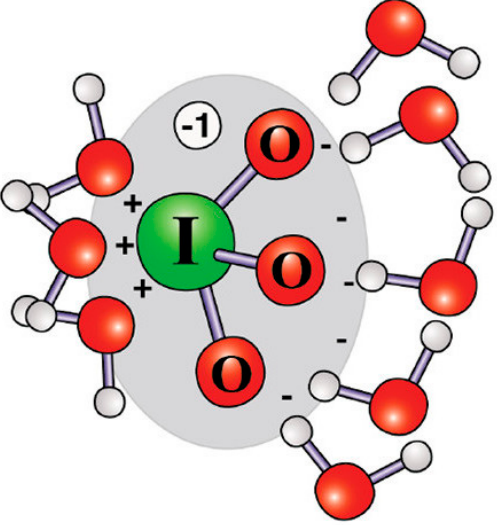
Figure 5. Schematic representation of an IO 3 − ion surrounded by hydrating water molecules in the two regions that bear positive (left) and negative (right) charges. Reprinted with permission from Ref. [38]. Copyright 2011 American Chemical